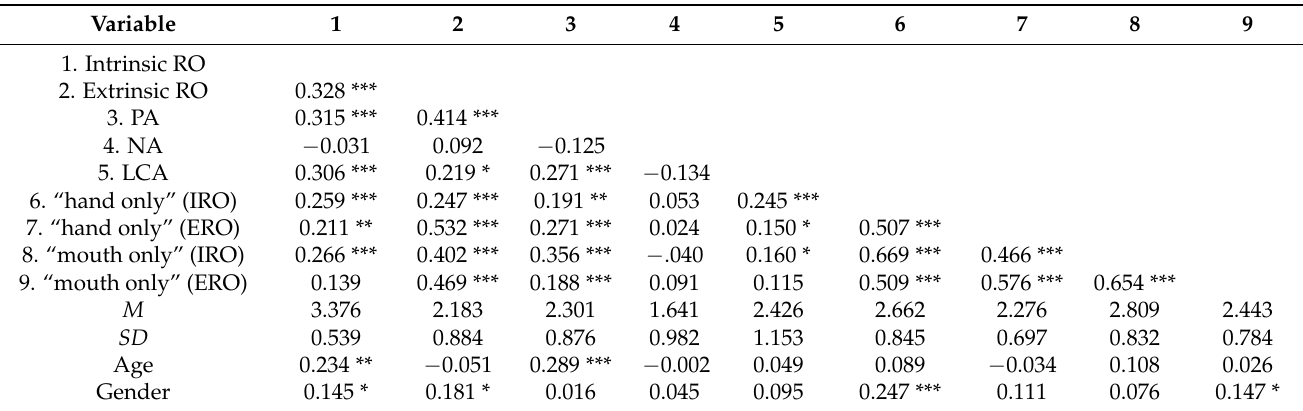
Table 1. Descriptive statistics for the study 1